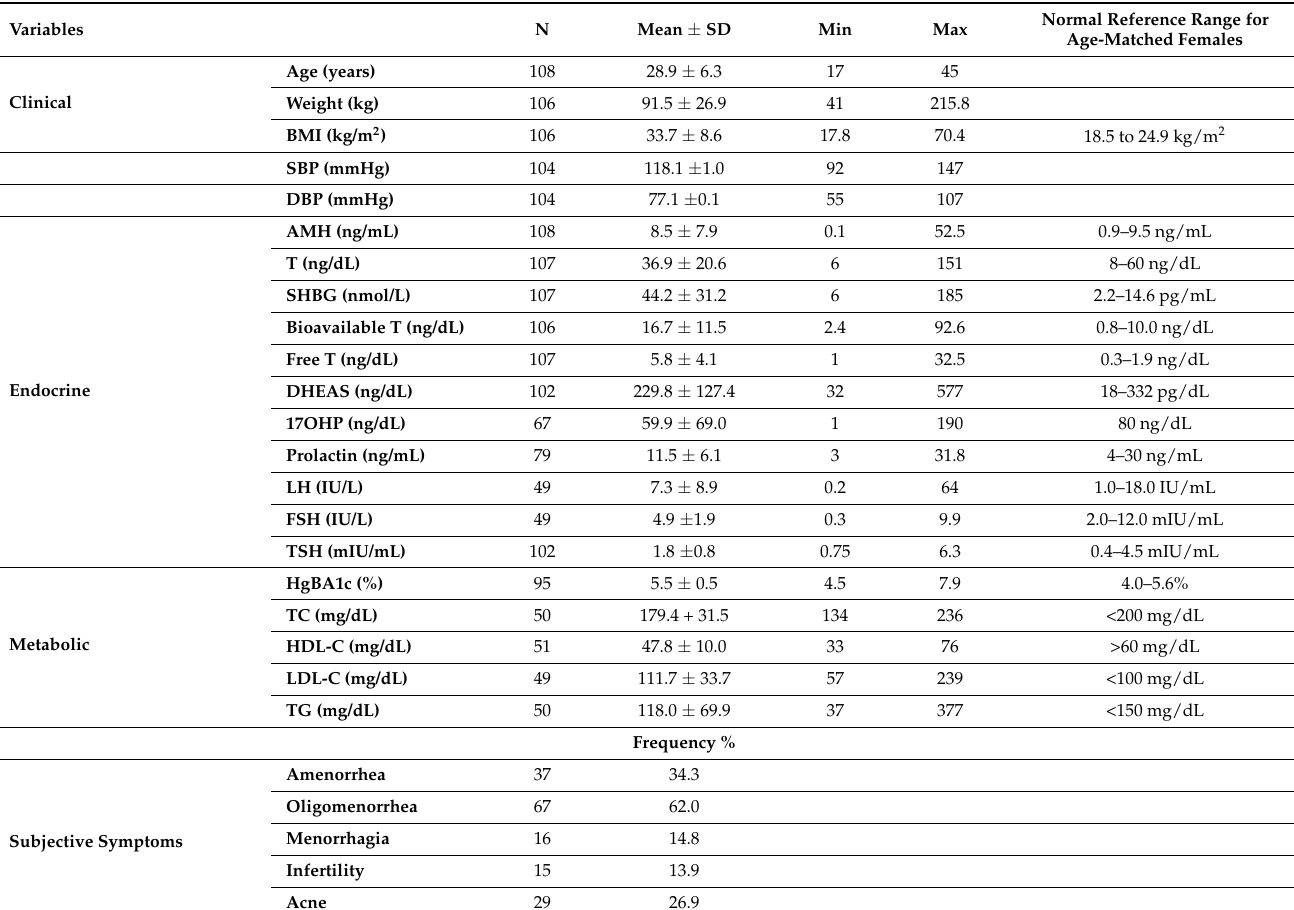
Table 1. Clinical and biochemical variables of the women with